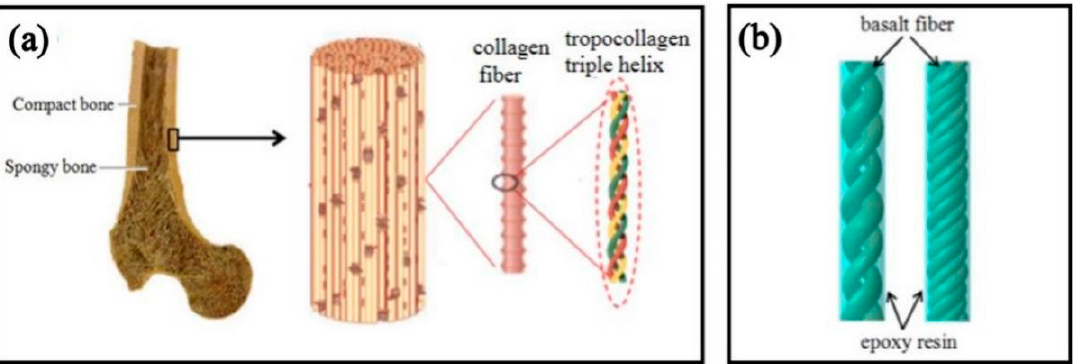
Figure 1. ( a ) Hierarchical structure of the bone [30]; ( b ) tropocollagen-inspired basalt fiber reinforced helical composite spring model.